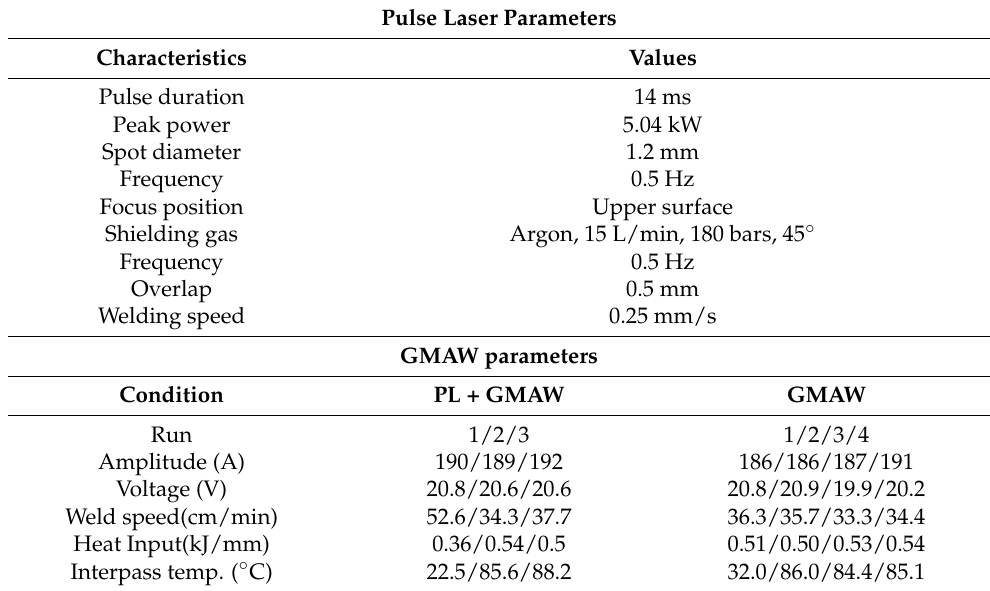
Table 2. Welding parameters used in PL and GMAW processes.